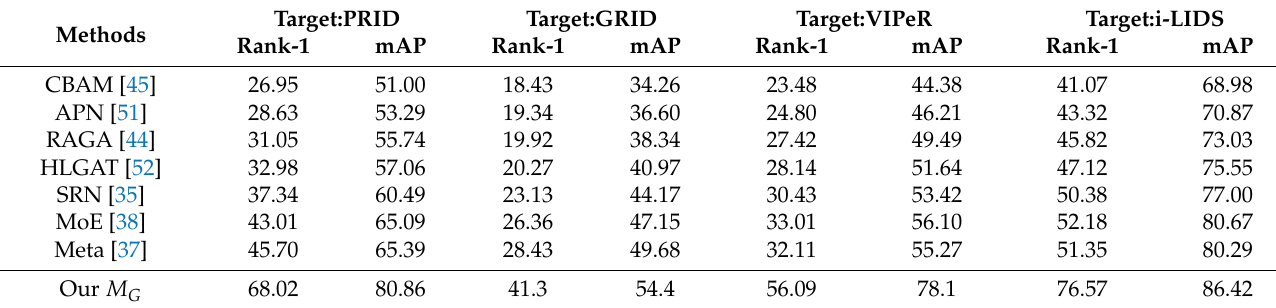
Figure 14. Open-World Scenario where it is not necessary that all the Queries have match in Gallery view. Thus, the metric M G needs to be robust against unknown persons seen in the open world while the target is moved out of perception. Table 5. Results on Open-World Re-ID.